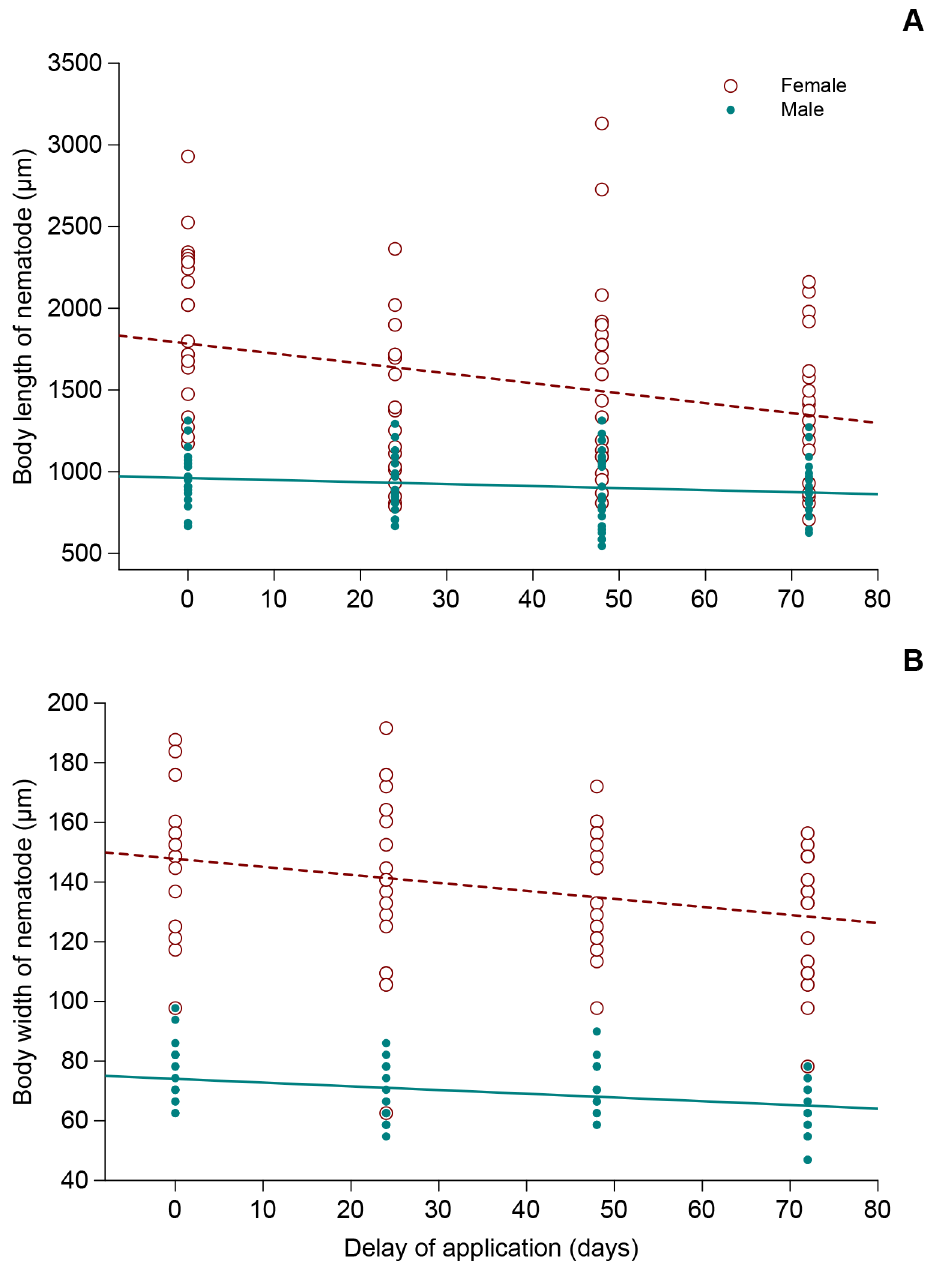
Fig 6. Linear regressions between the body size parameters and nematode inoculation delay. Body length (A) and body width (B) of S . feltiae adults developed inside cadavers of L . decemlineata last-instar larvae and following I . fumosorosea CCM 8367